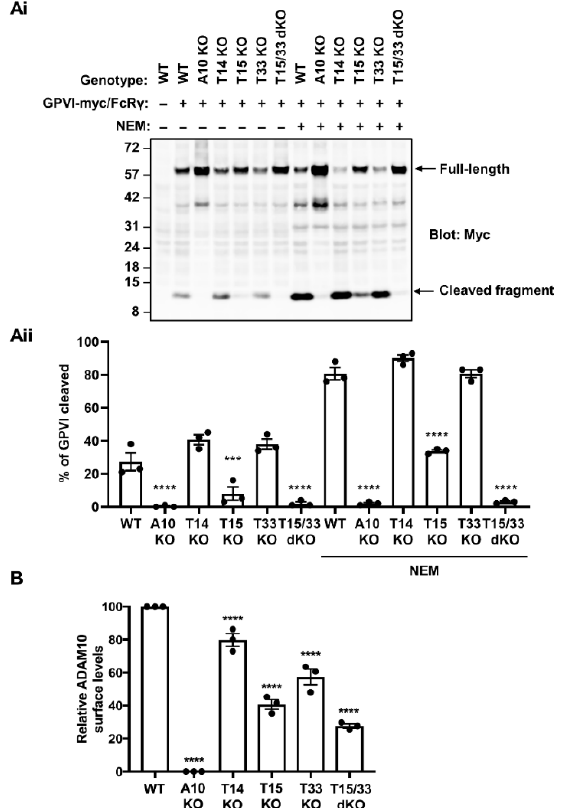
Figure 1. GPVI cleavage is dependent on Tspan15 and Tspan33 in transfected HEK-293T cells. ( Ai ) Wild-type (WT), ADAM10-knockout (A10 KO), Tspan14-knockout (T14 KO), Tspan15-knockout (T15 KO), Tspan33-knockout (T33 KO) and Tspan15/33 double knockout (T15/33 dKO) HEK-293T cells were transfected with expression constructs for C-terminally Myc-tagged human GPVI and FcR γ